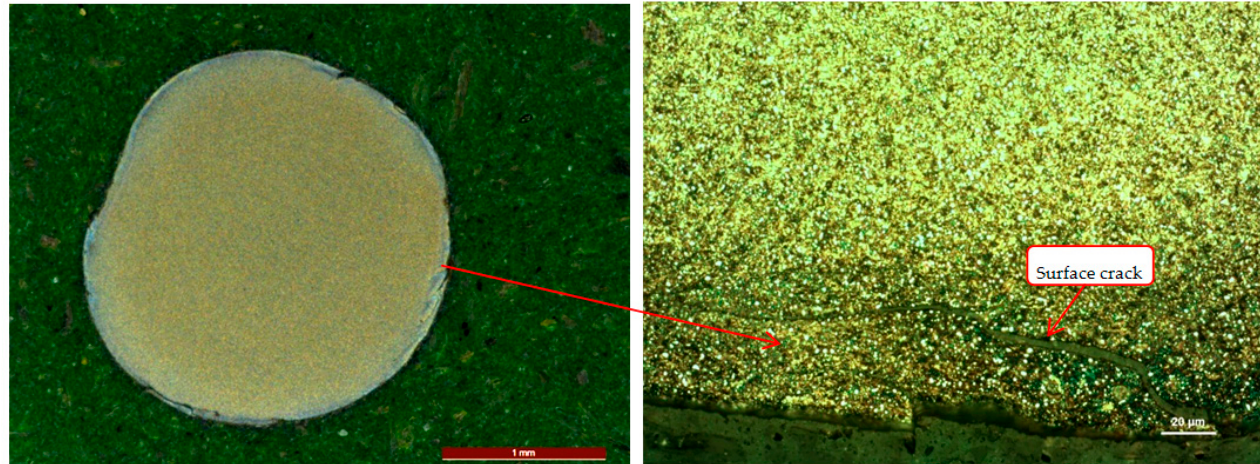
Figure 12. Microstructure and cracks of the heavily damaged ball. The microstructure of the cage is normal and consists of an α and β phase [34], as shown in Figure 13. Cracks located on the surface of the angle between two adjacent pockets can be seen, as shown in Figure 14.